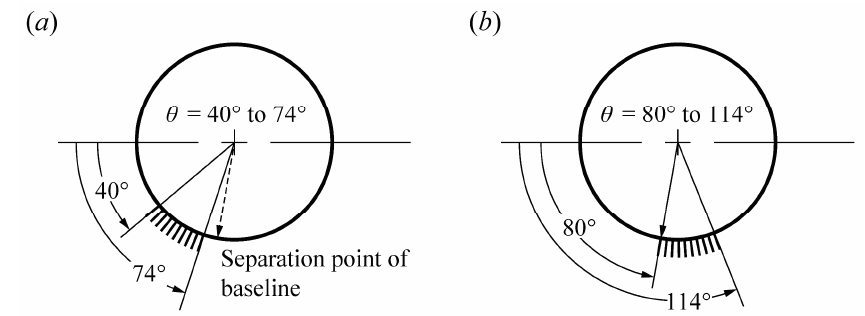
Figure 7. Schematic of the coating position and configuration: ( a ) Microfiber coating at θ = 40°, coating position is θ = 40°–74°; ( b ) Microfiber coating at θ = 80°, coating position is θ = 80°–114°.